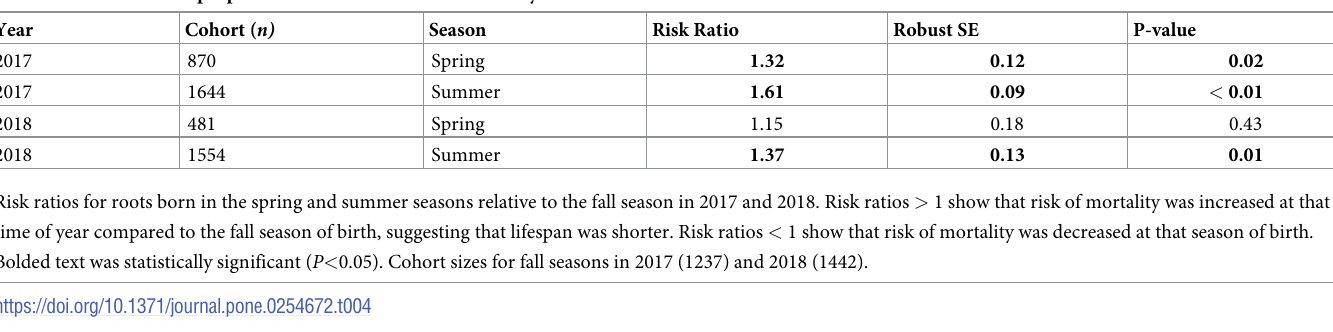
Table 4. Season of birth proportional hazards table for different years.